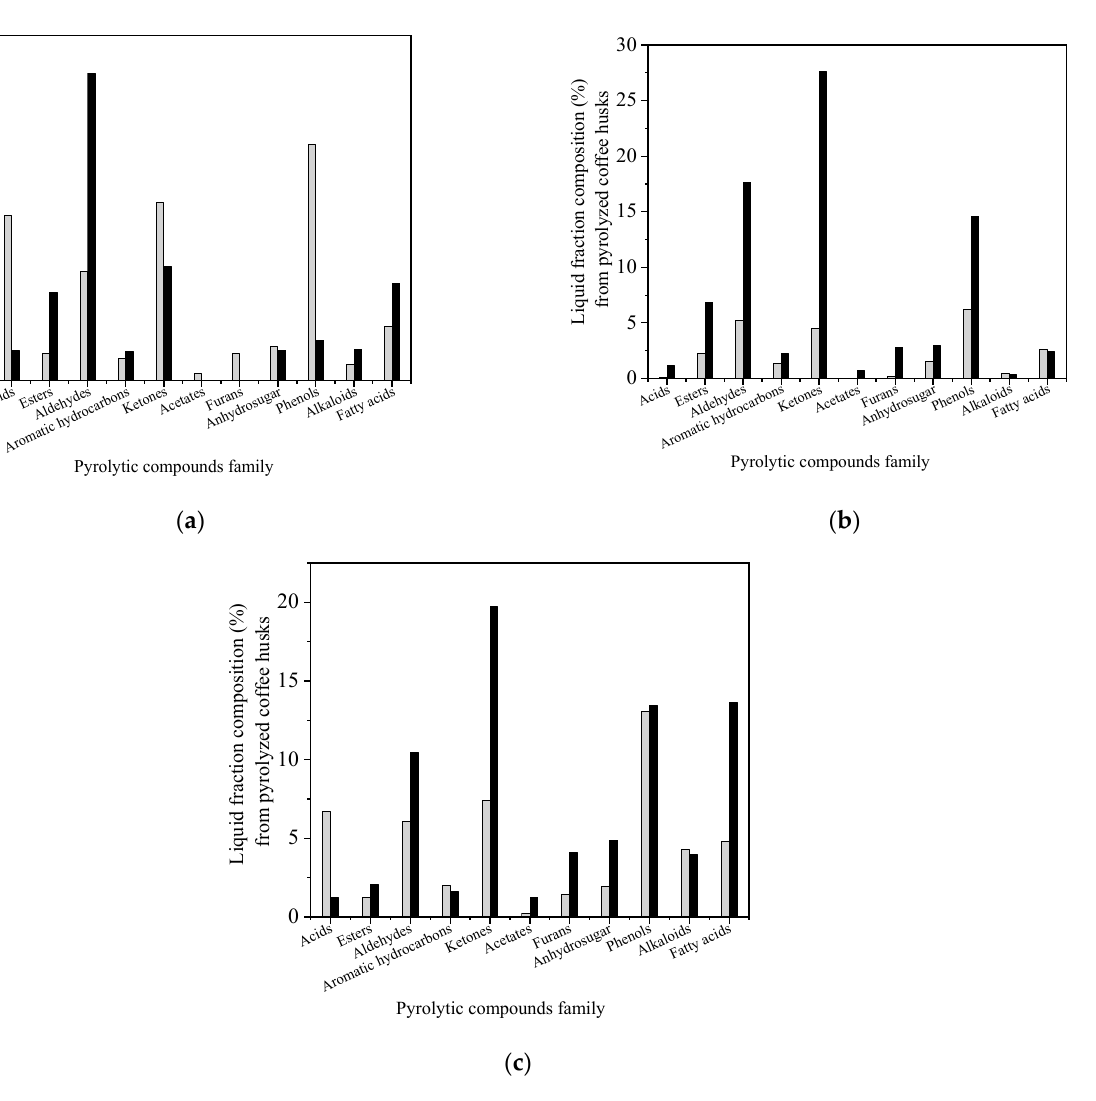
Figure 5. Pyrolytic compounds in the liquid fraction obtained from untreated and HNO 3 (0.1 wt%)/H2 S O 4 (0.1 wt%) washed coffee husks after fast pyrolysis at: ( a ) 400 °C; ( b ) 500 °C; ( c ) 600 °C. Symbols:  untreated biomass;  treated biomass.